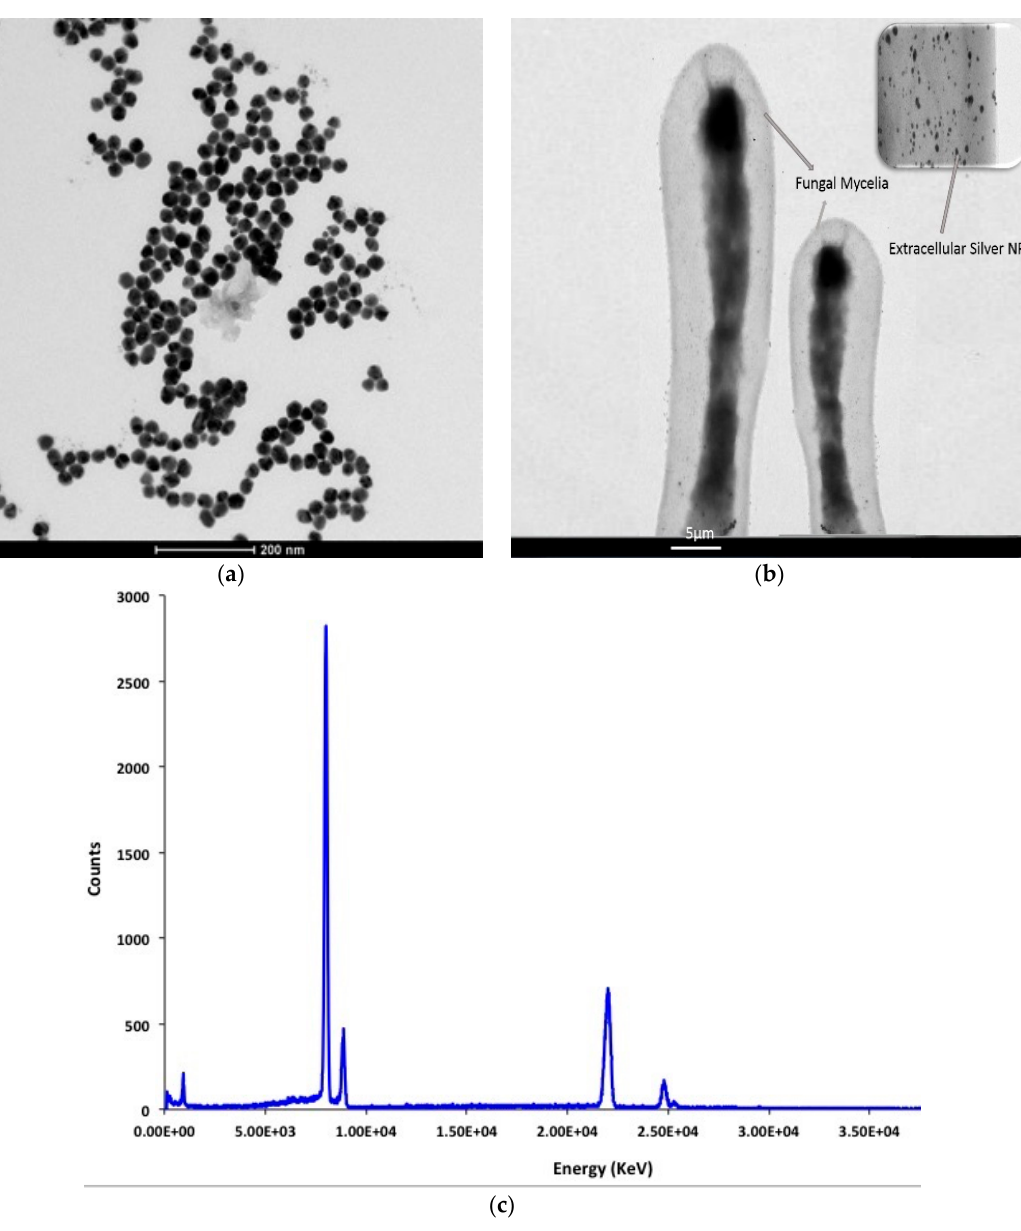
Figure 4. Transmission Electron Microscopy (TEM) images of silver nanoparticles synthesized by F. oxysporum show: ( a ) spherical particles with mean size distribution 40 ± 5 nm; ( b ) extracellular synthesis by fungal mycellia; and ( c ) EDX results,